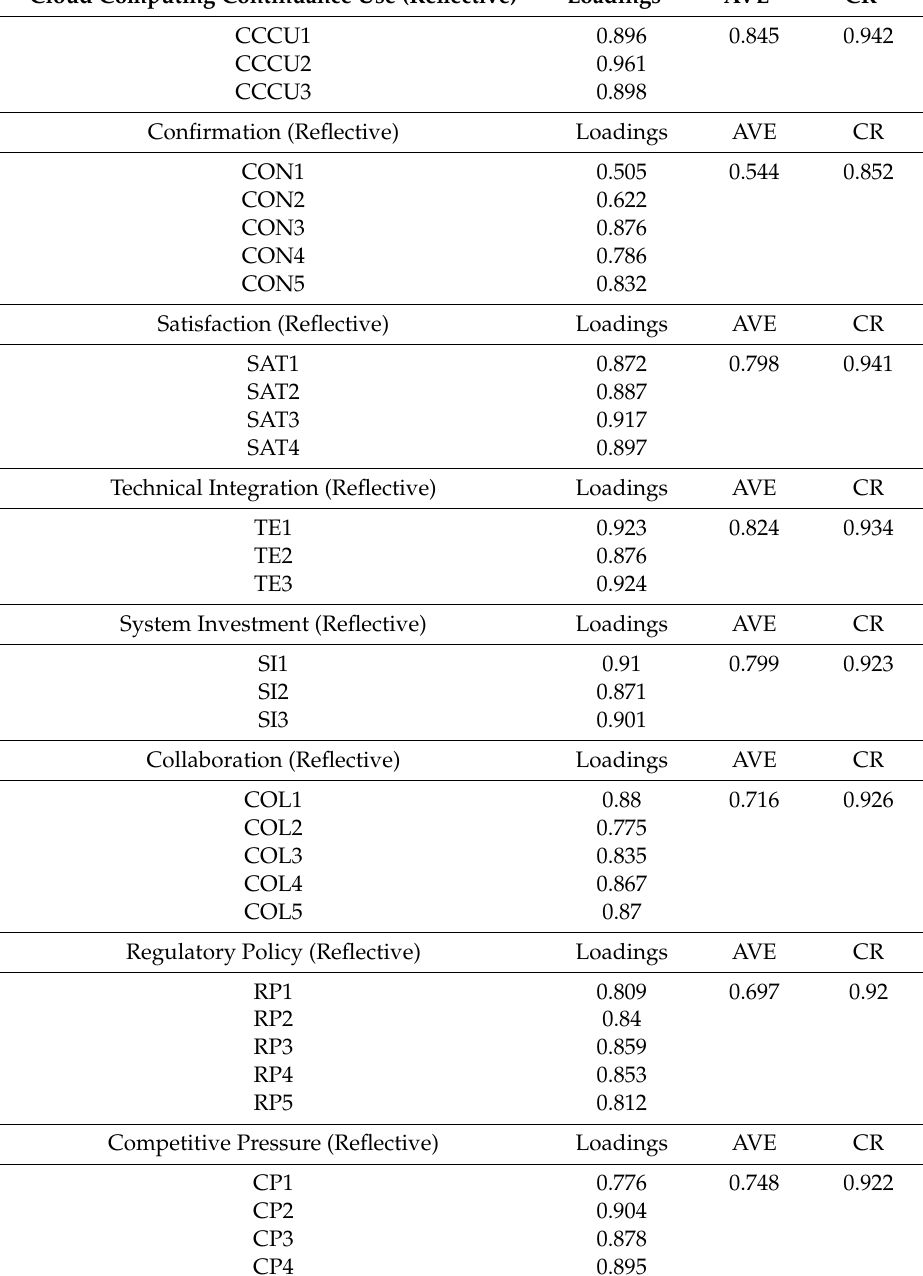
Table 6. Quantitative Assessment of Measurement Model